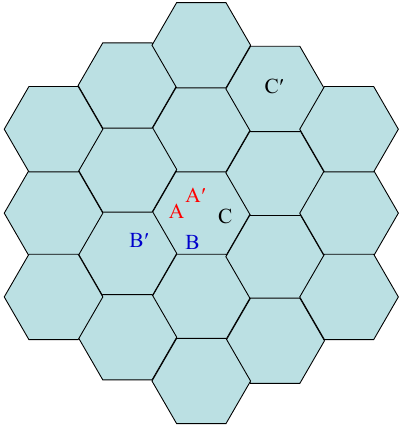
Figure 3. Some cases of locations of user equipment (UE) pairs